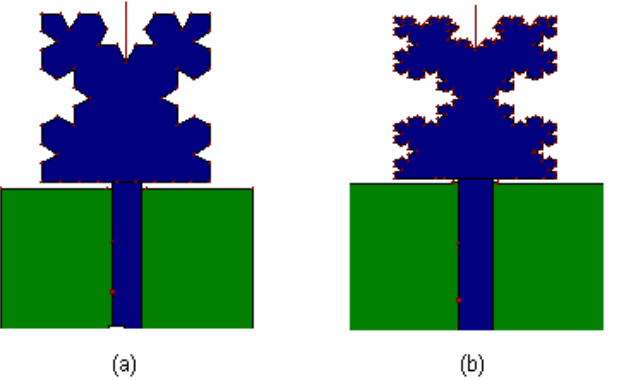
Figure 2: The layouts of the modeled monopole antennas with (a) 2nd, and (b) 3rd iteration Koch fractal geometry.